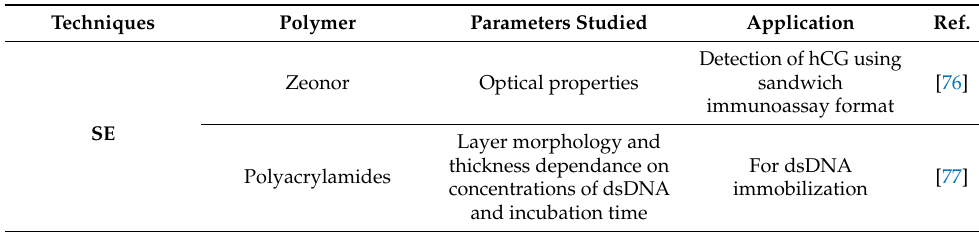
Table 1. The summary of SE and QCM-D application for the assessment of polymer layers and for the application in